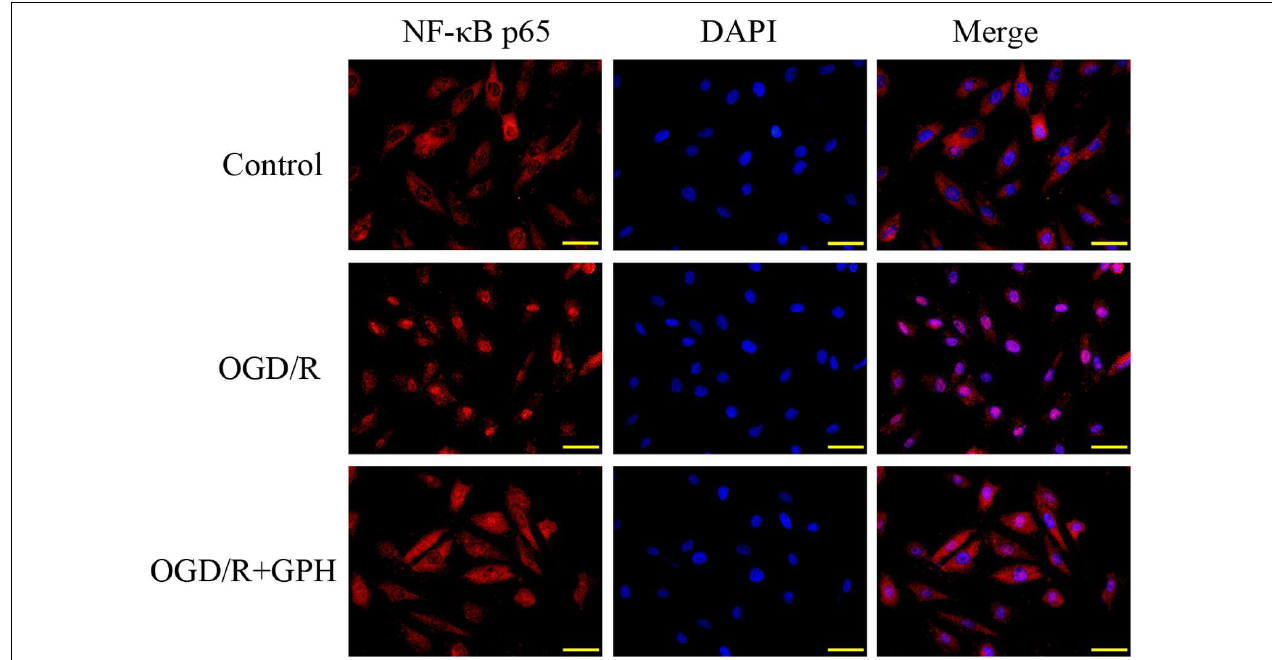
FIGURE 4 | GP suppressed the nuclear translocation of NF- κ B p65 induced by OGD/R in H9c2 cells. Scale bar: 50 µ m.